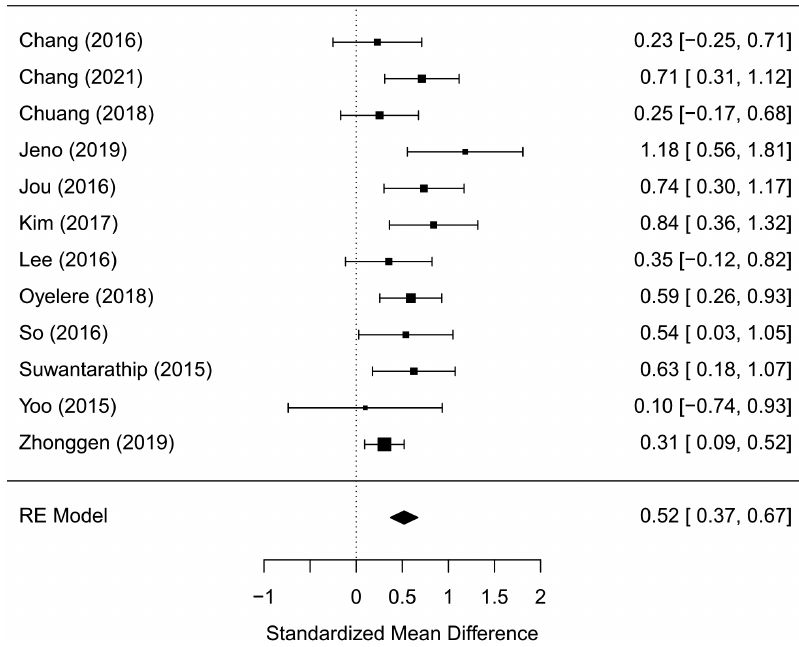
Fig. 1. Forest plot showing individual and overall effect sizes of mobile learning interventions The I 2 is equal to 29.25%, which suggests a low level of heterogeneity and may inform us that the proportion of the observed variance is likely to account for sampling error rather than differences in the effect sizes [36]. Further, there were no missing studies as can be judged from Figure 2, since no open circles can be observed on the right side of the funnel plot. Therefore, it is safe to claim the lack of publication bias in these